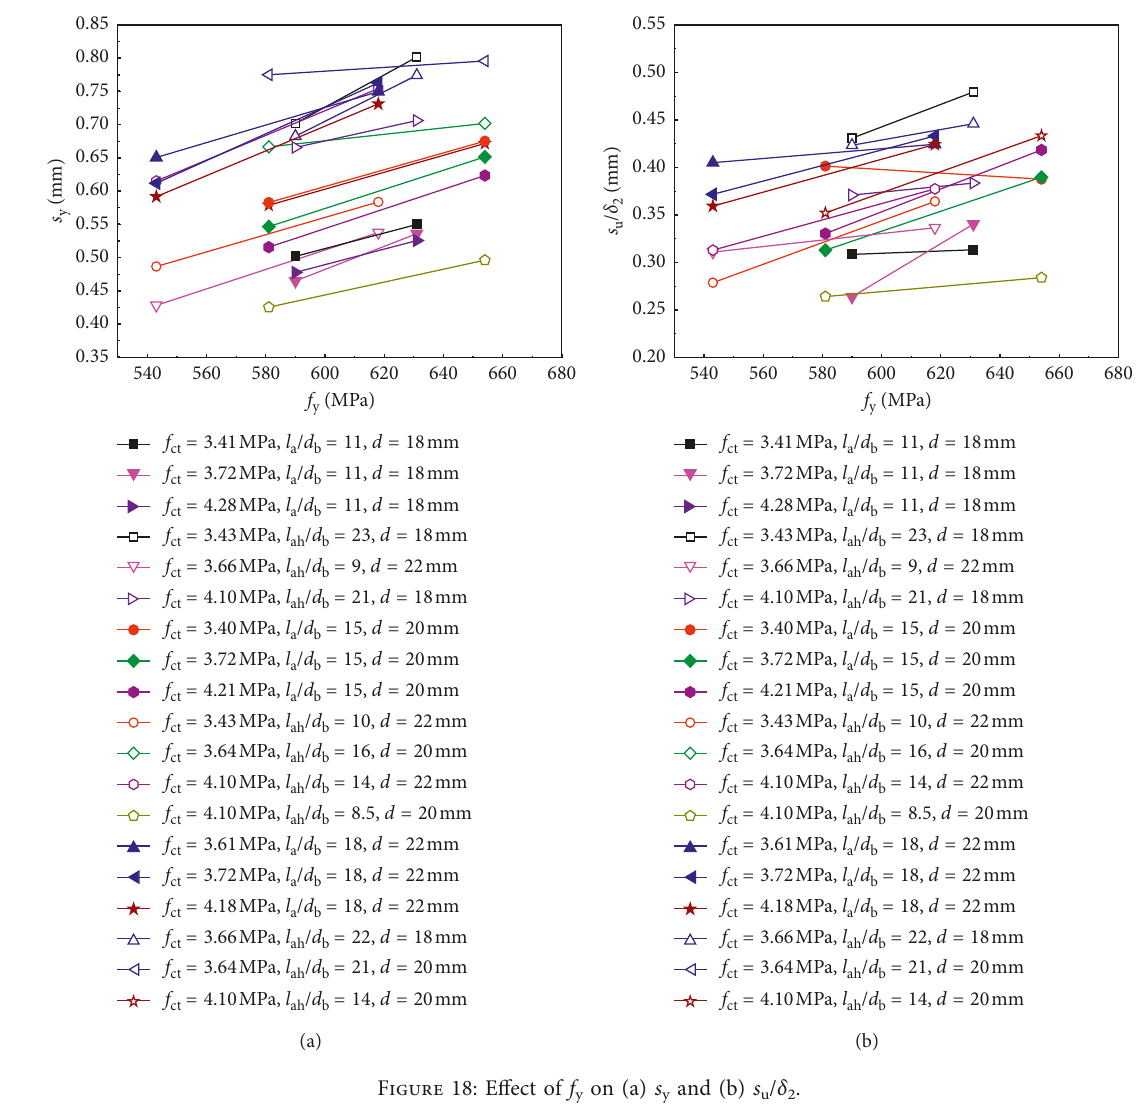
Figure 18: Effect of f y on (a) s y and (b) s u / δ 2